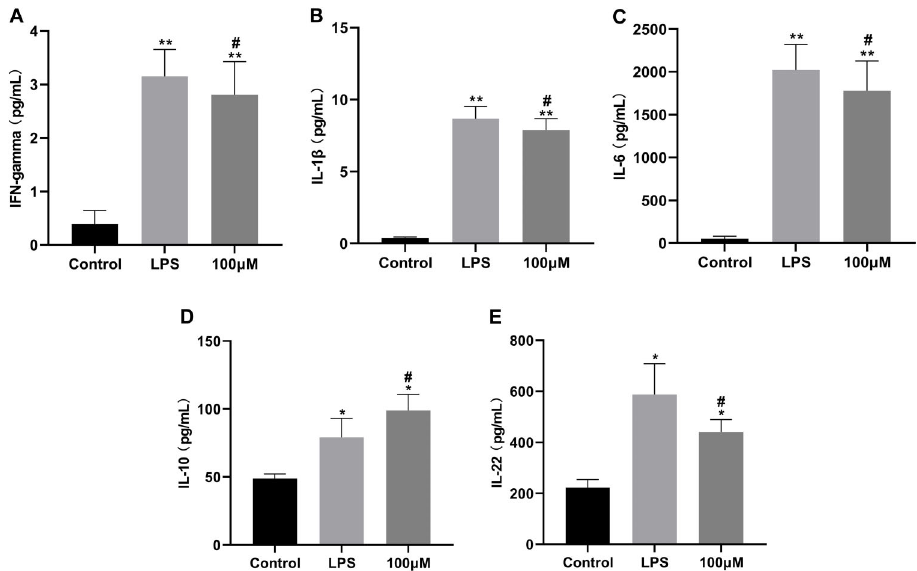
Figure 6. Effect of 4 ’ -O- b -D-glucosyl-5-O-methylvisamminol (4GMV) on lipopolysaccharide (LPS)-induced production of cytokines in RAW 264.7 cells. RAW 264.7 cells were pretreated with 4GMV (100 m M) for 1 h prior to treatment with 1 m g/mL lipopolysaccharide (LPS). After 24 h, the culture supernatants were analyzed using a multiplex cytokine assay. A – E , Production of interferon (INF)- g , interleukin (IL)-1 b , IL-6, IL-10, and IL-22, respectively. Data are reported as means ± SD (n=3) from three independent experiments. *P o 0.05 and **P o 0.01 compared with the control group; # P o 0.05 compared with the LPS group (ANOVA followed by